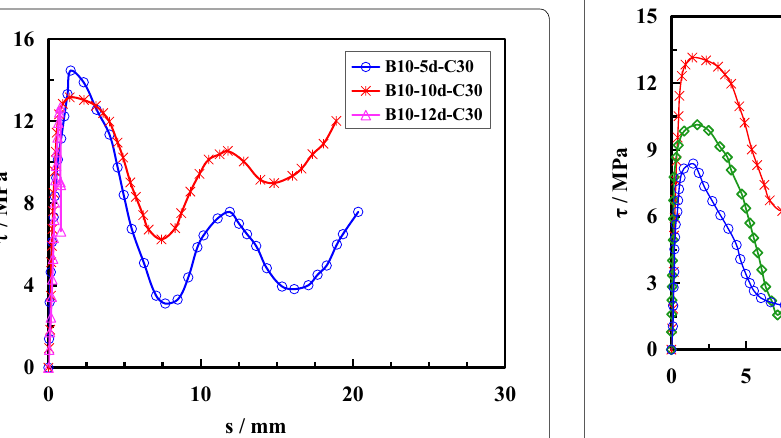
Fig. 11 τ - s curves of BFRP rebar—different strength grade coral